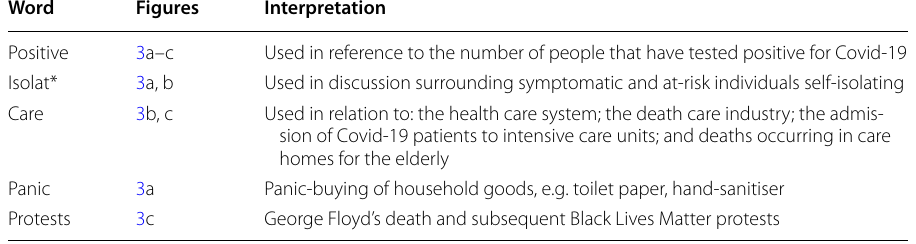
Table 2 Words belonging to the Affect LIWC category that appear in the primarily Death-based clusters in the three snapshot word co-occurrence networks shown in Fig. 3a–c. The middle and right columns indicate in which snapshots they are most prominent, and the likely explanation for their association with the concept of death during the pandemic